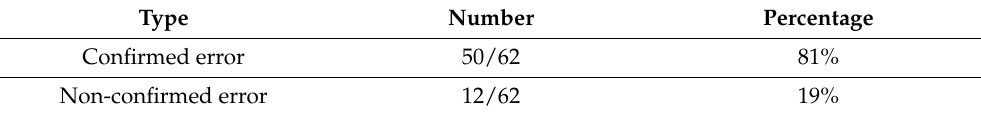
Table 2. Classification of junction errors based on manual evaluation of the alignment of ONT reads on the Hi-C-scaffolded H. lacustris genome assembly. The table shows the number and percentage of errors identified by alignment to optical maps and confirmed by manual inspection of ONT read mapping at the conflict site.